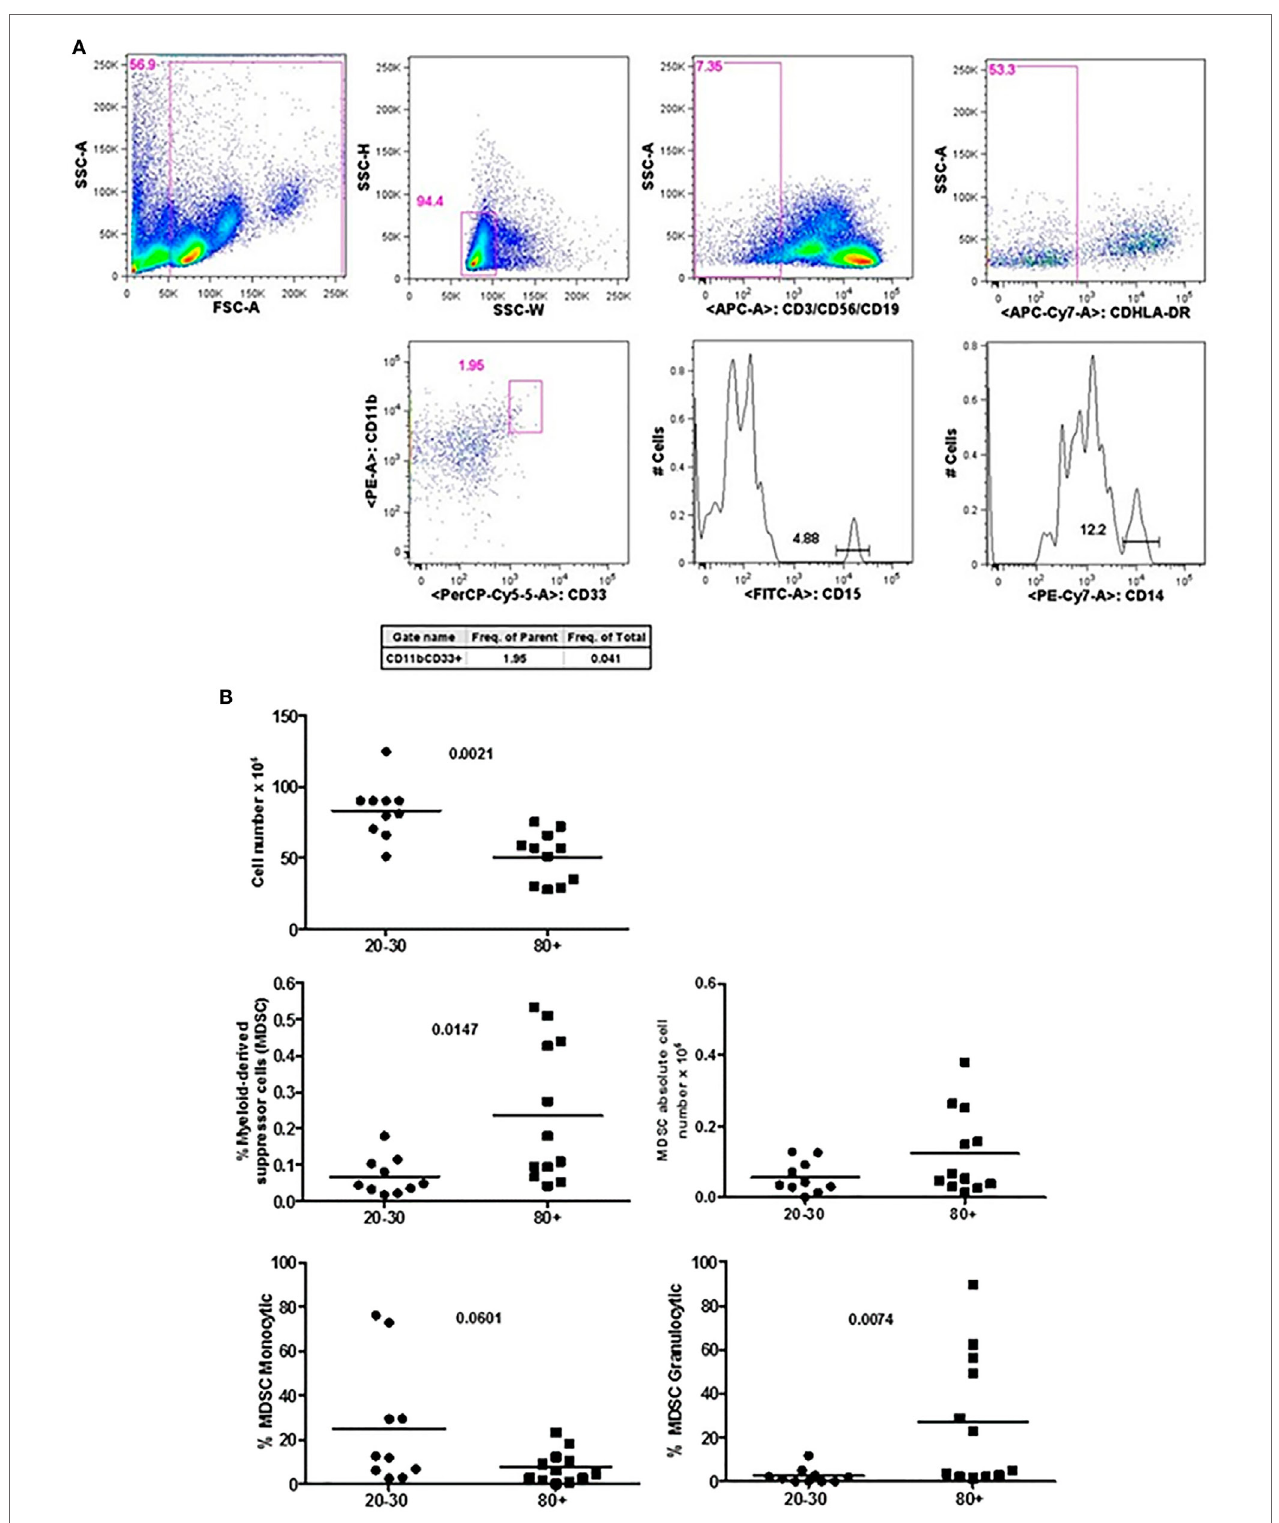
FigUre 1 | Representative flow cytometry plots showing gate strategy for myeloid-derived suppressor cells (MDSC) frequency. Gate in live cells (FSC-A × SSC-A), doublets exclusion (SSC-H × SSC-W), gate in lineage negative cells (CD3 − CD56 − CD19 − ), gate in HLA-DR low/neg cells, gate in CD33 + CD11b + cells. Gate in granulocytic (CD15 + ) and monocytic (CD14 + ) cells (a) . Number of circulating leukocytes, MDSC (% MDSC) frequency, absolute number of MDSC, and frequency of monocytic and granulocytic MDSC in individuals of 20–30 years and 80 + years old individuals (b)